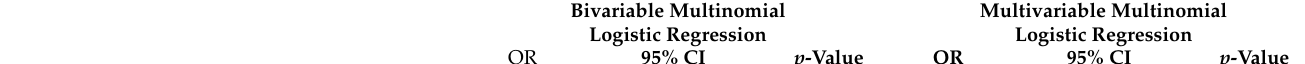
Bivariable Multinomial Logistic Regression